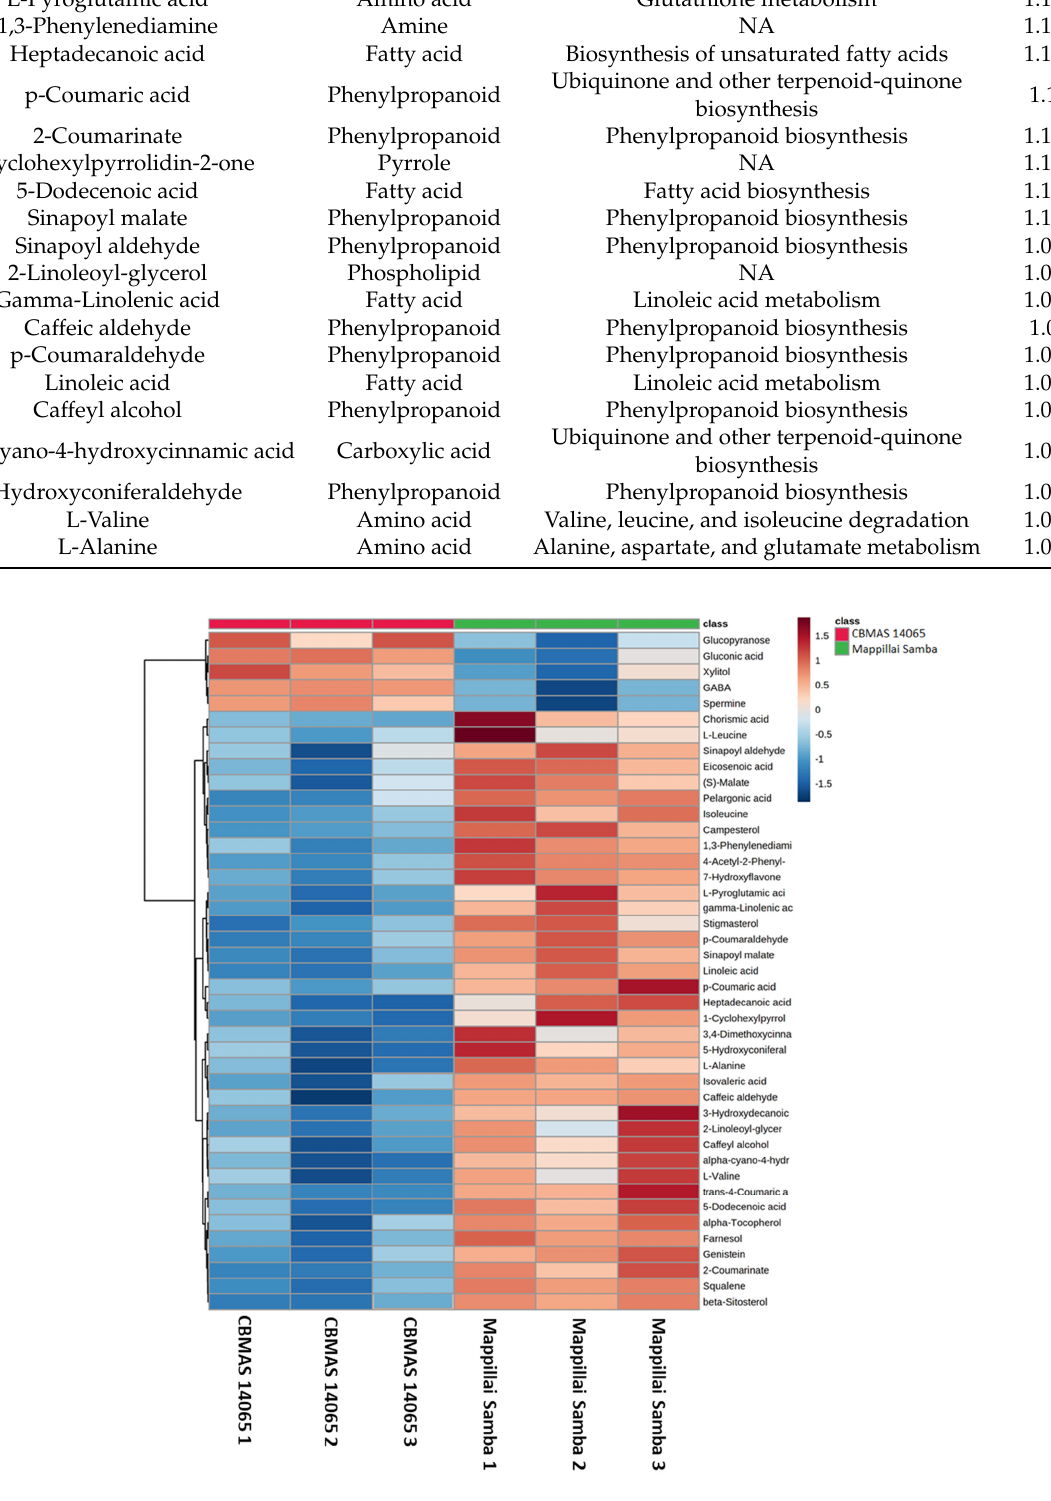
Figure 6. Heat map analysis showing the abundance of PLS-DA VIP metabolites between the grains of Mappillai Samba and CBMAS 14065.